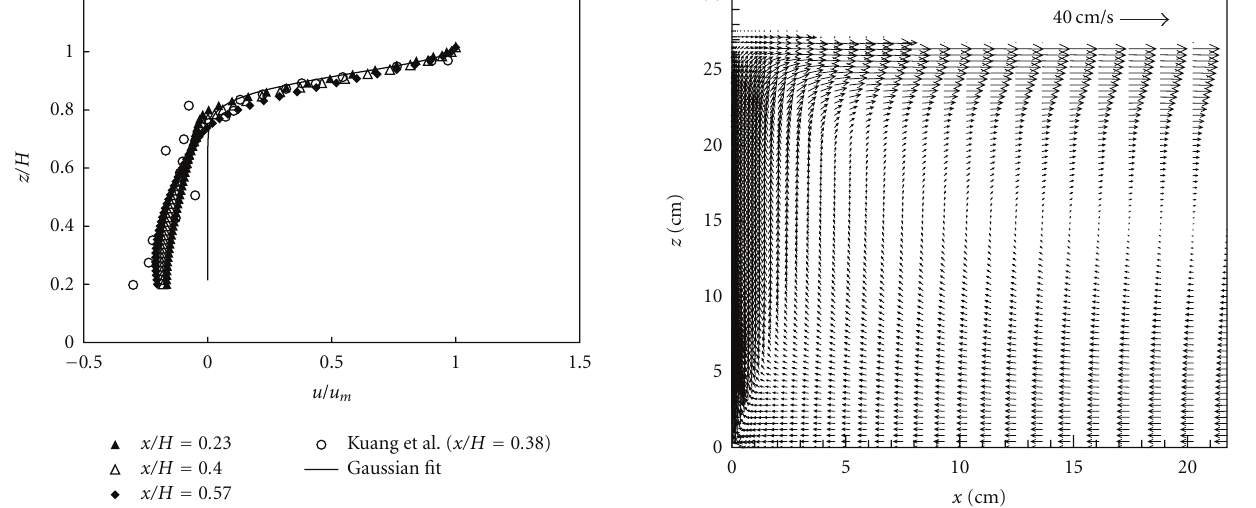
Figure 16: Recirculation zone predicted using RNG scheme.